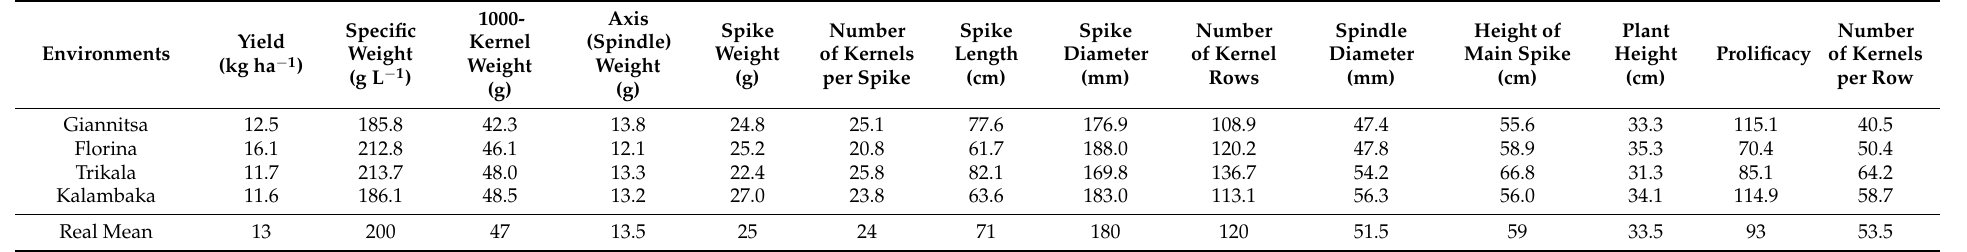
Table 2. Trait stability index ( x / s ) 2 across environments for tested traits: yield (kg ha − 1 ), specific weight (g L − 1 ), 1000-kernel weight (g), axis (spindle) weight (g), spike weight (g), number of kernels per spike, spike length (cm) and diameter (mm), number of kernel rows, spindle diameter (mm), main spike and plant height (cm), prolificacy, and number of kernels per row.